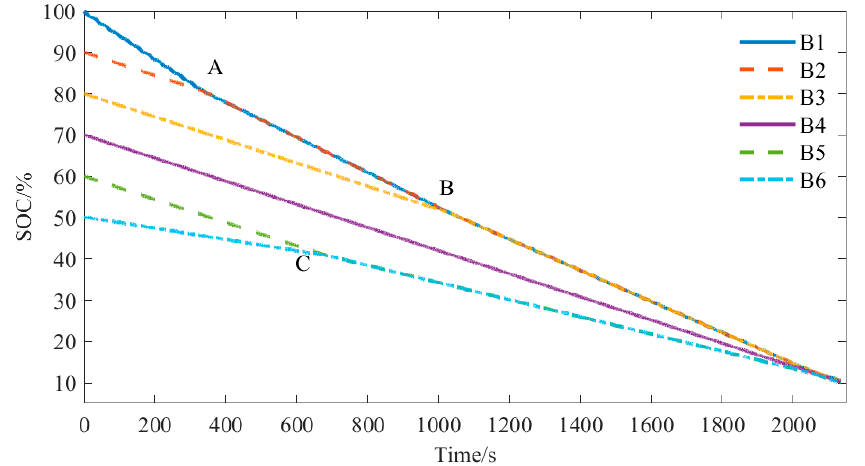
Figure 16. Equalization process in discharge state.